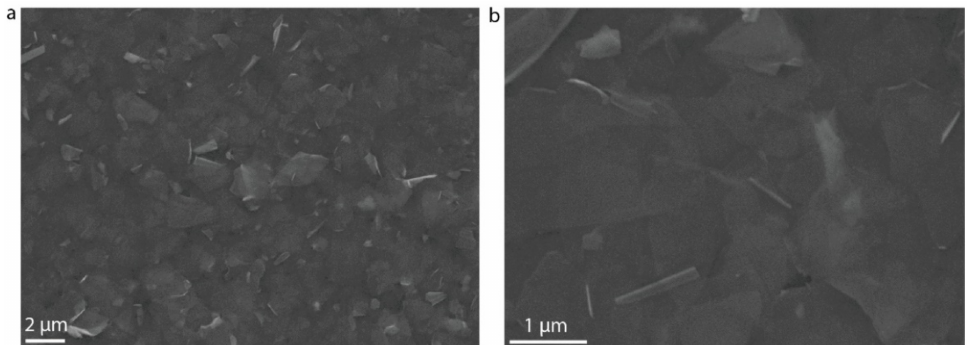
Figure 4. SEM image of LbL-assembled In 2 Se 3 thin films at different magnifications. ( a ) SEM image of LbL-assembled In 2 Se 3 thin films with 2 µ m scale bar. ( b ) SEM image of LbL-assembled In 2 Se 3 thin films with 1 µ m scale bar.